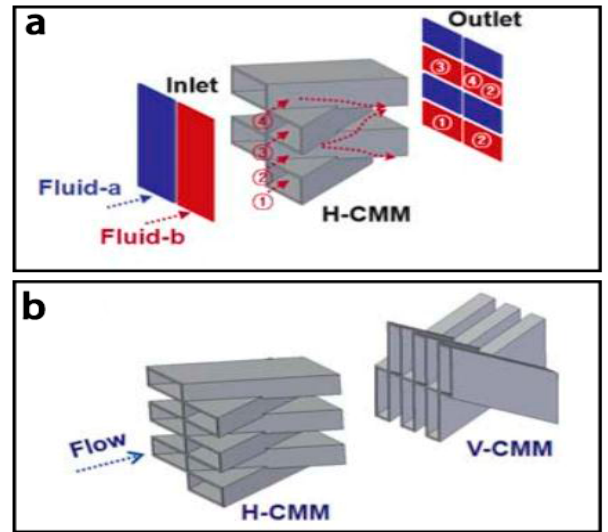
Figure 17. ( a ) Schematic of the lamination based micromixer with crossing manifold structure; ( b ) The horizontally crossing manifold micromixer (H-CMM) and the vertically crossing manifold micromixers (H/V-CMM). Reproduced with permission from [141].